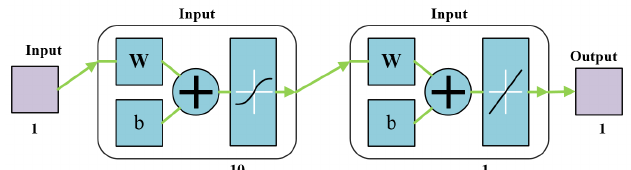
Figure 12. Structure of neural network used to fit the mathematical relation among BD-rate loss, time saving and thresholds. Number under blocks represents the number of neurons in corresponding